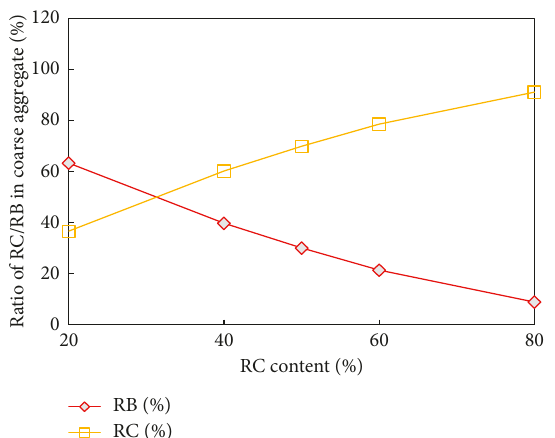
Figure 6: Content of recycled concrete before crushing to ratio of RB/RC in crushed coarse